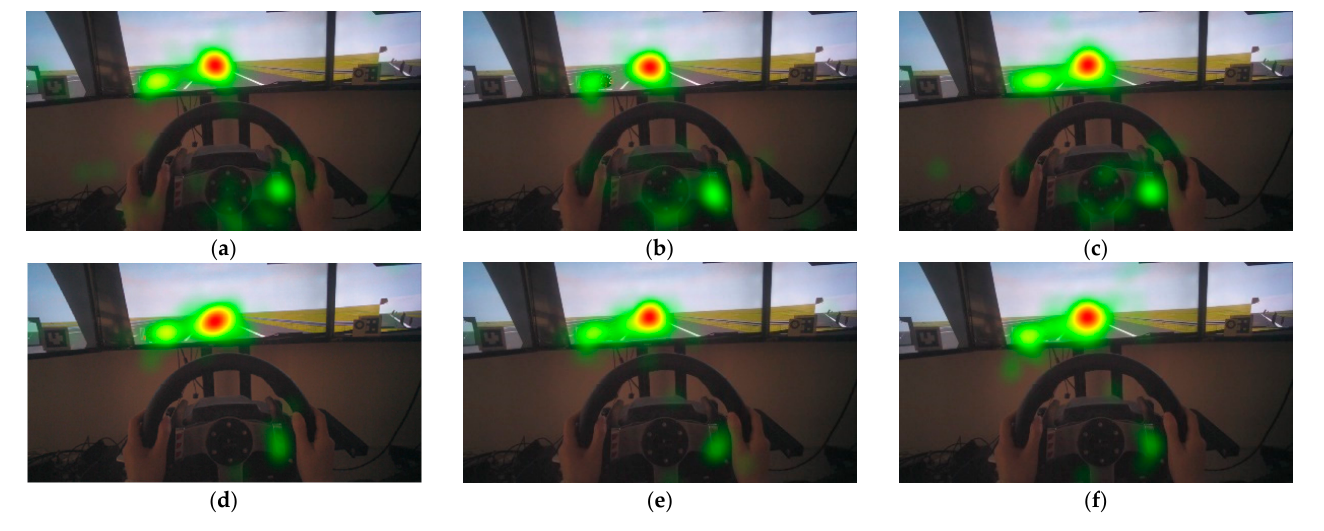
Figure 8. Thermal distribution of viewpoint: ( a ) non-critical; ( b ) most-critical; ( c ) sub-critical; ( d ) non- critical with MR; ( e ) most-critical with MR; ( f ) sub-critical with MR.